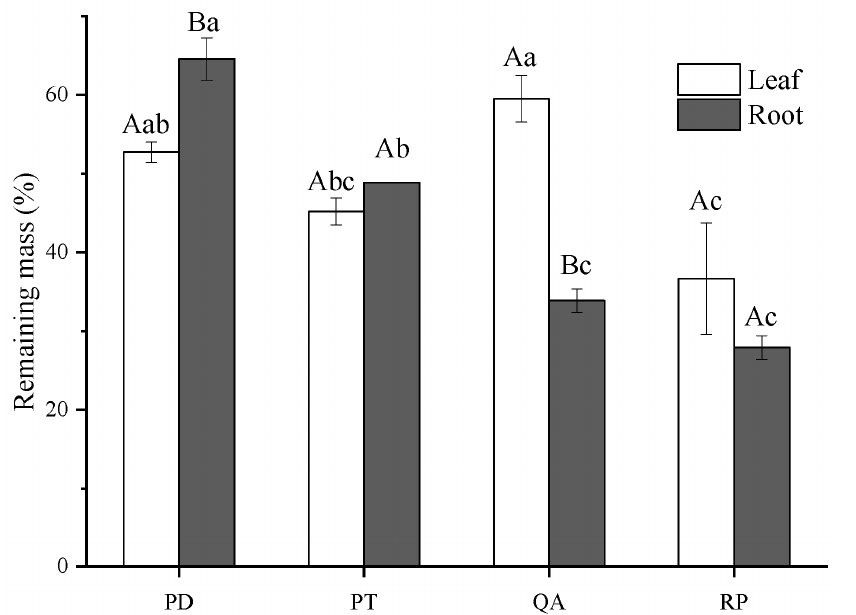
Figure 2. The remaining mass for leaf and root litters of the four species after decomposition for one year at Mount Tai. RP: R . pseudoacacia , QA: Q . acutissima , PD: P. densiflora and PT: P . tabulaeformis . Different capital letters indicate significant differences between leaf and root for the same species. Different lowercase letters signify significant differences among different species for the same organ ( p < 0.05). All data are expressed as the mean ± SE.